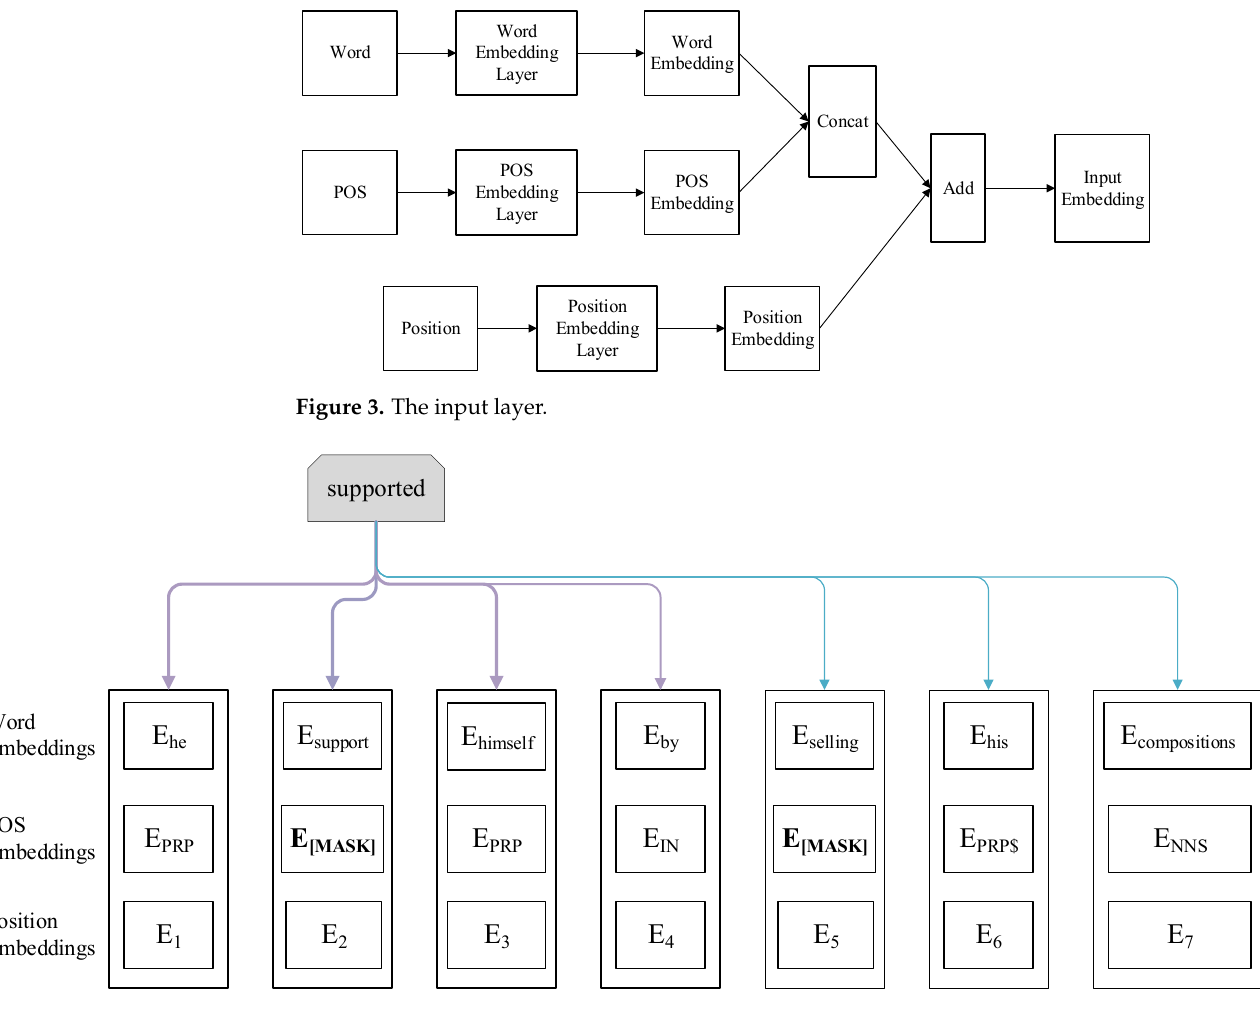
NNS Figure 2. Masking partial POS tags. The POS tags of the token supported and the token selling are masked.